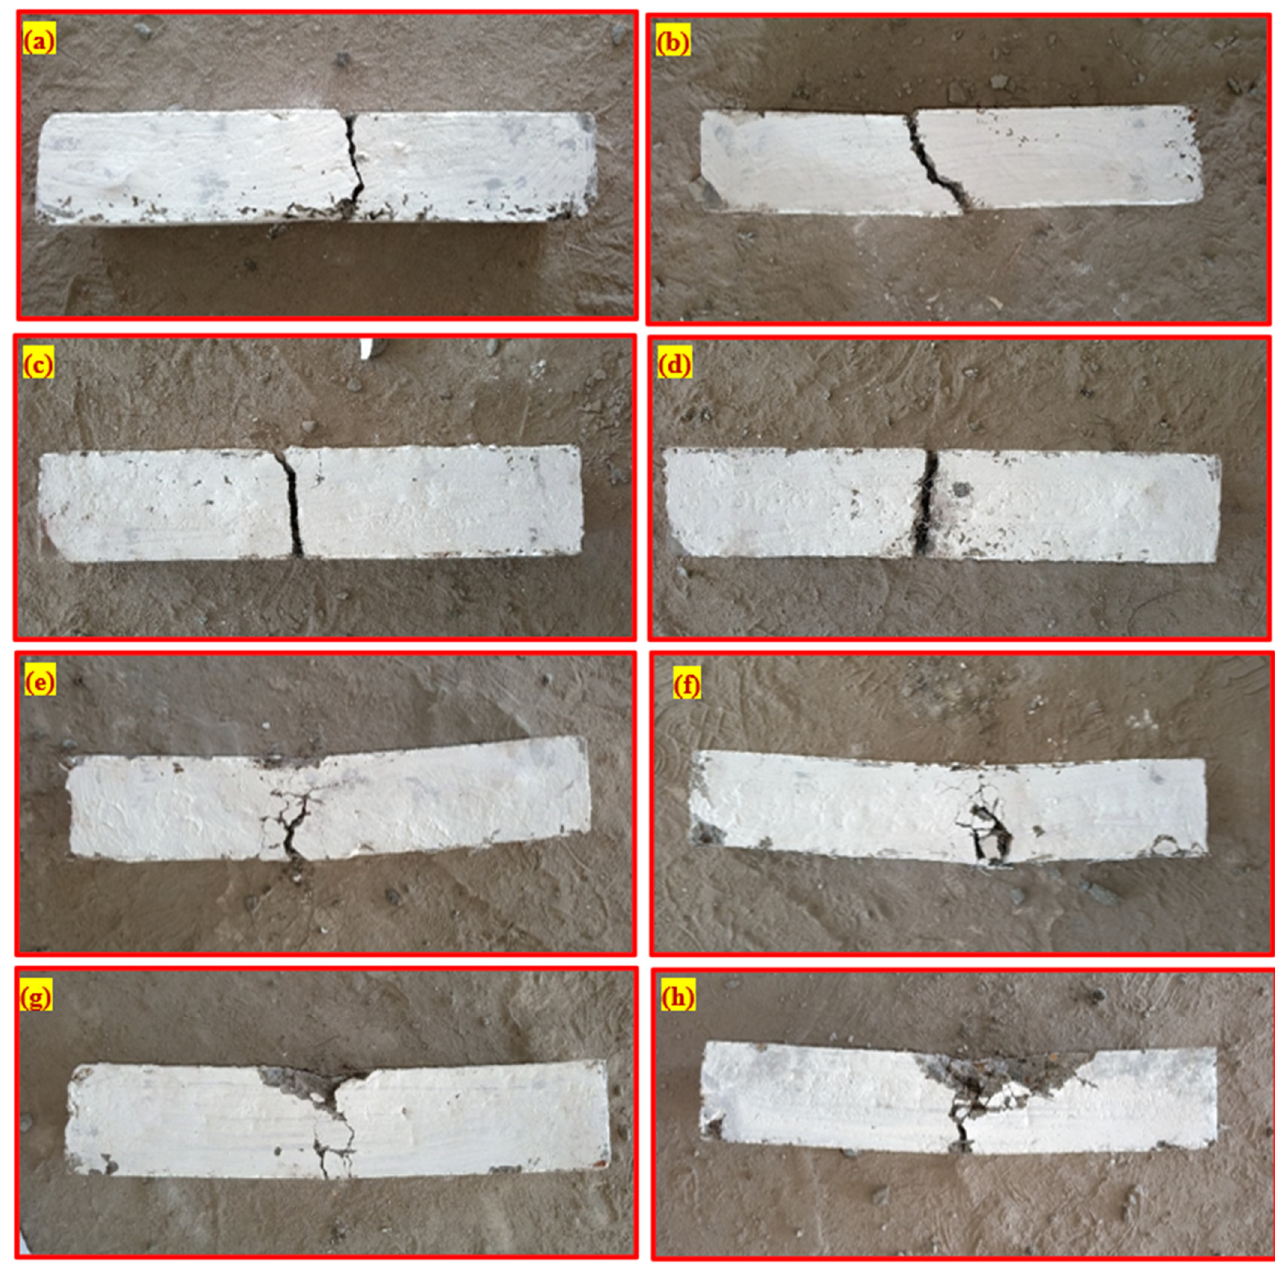
Figure 9. Failure mode of beams. ( a ) F0, ( b ) F-M0, ( c ) F-M1, ( d ) F-M2, ( e ) F-M3, ( f ) LF-M1, ( g ) LF-M2 and ( h ) LF-M3.